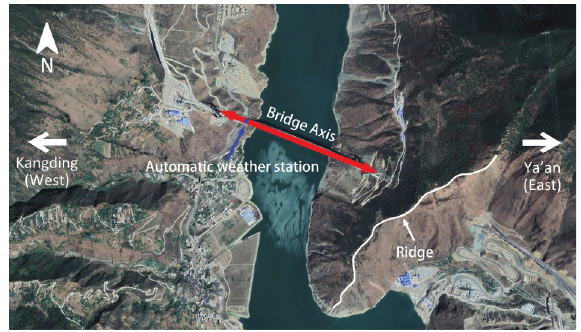
Figure 2: Terrain at bridge site (captured from Google